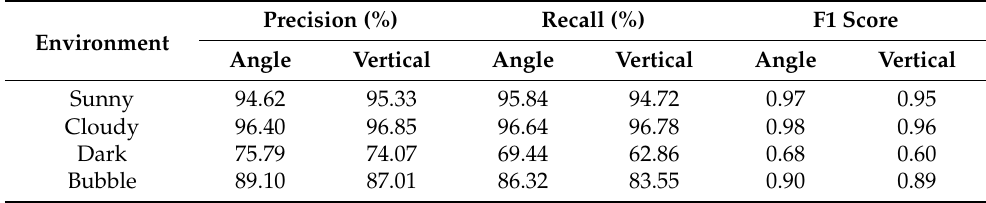
Table 4. Detection results under four different underwater shooting conditions.